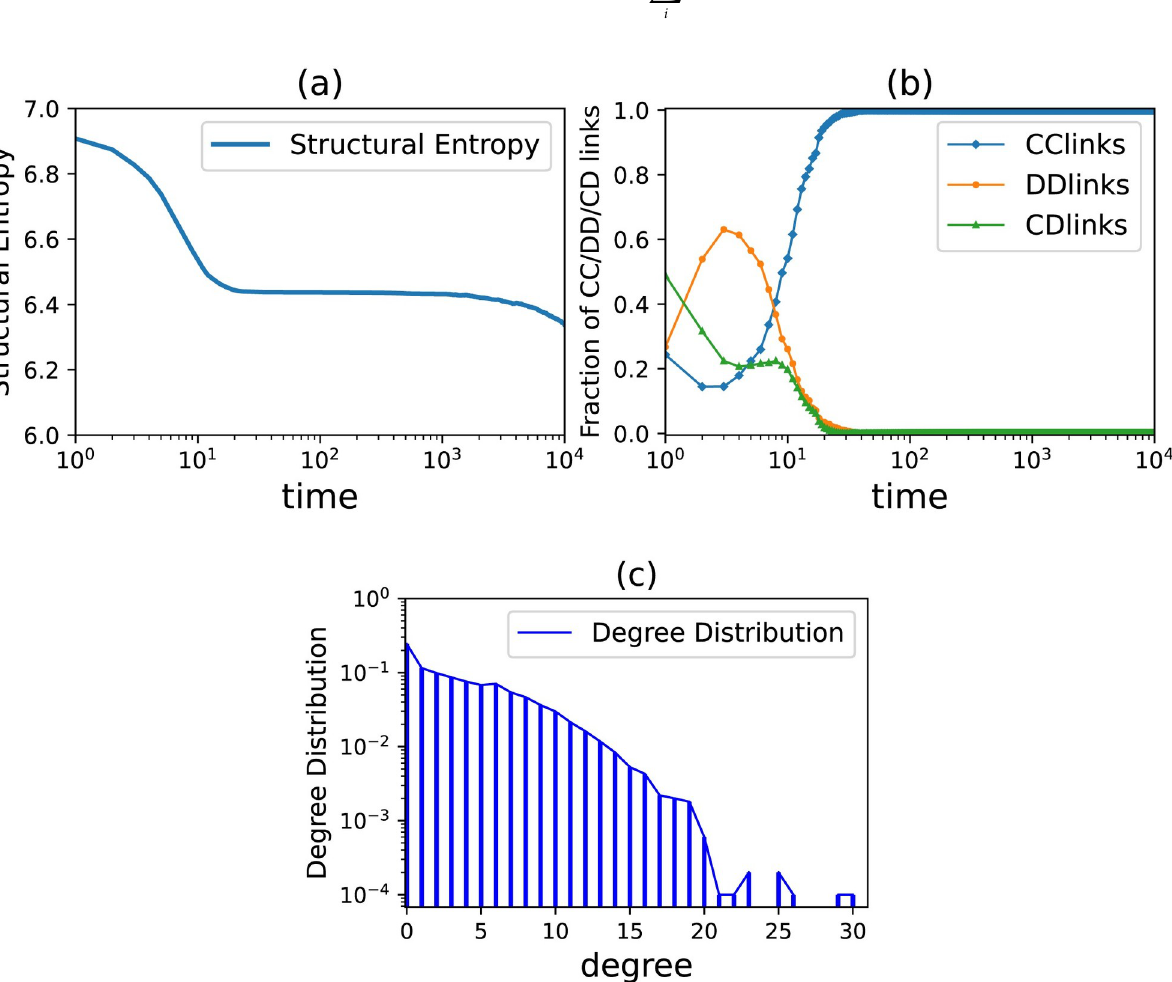
Fig 5. The changes of network indicators during the evolution of partner switching. (a) Time evolution of network structure entropy, (b) The time evolution of CC/CD/DD connection fraction in network, (c) Degree distribution in the evolutionarily stable network. N = 10000, t = 10000, T = 20, α = 5, β = 5, ^ k ¼ 4 and ω =